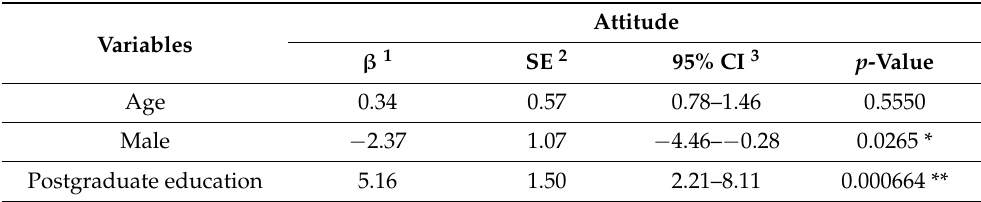
Table 4. Bivariate analysis of Attitude with socio-demographic factors such as age, gender and postgraduate education. Variables